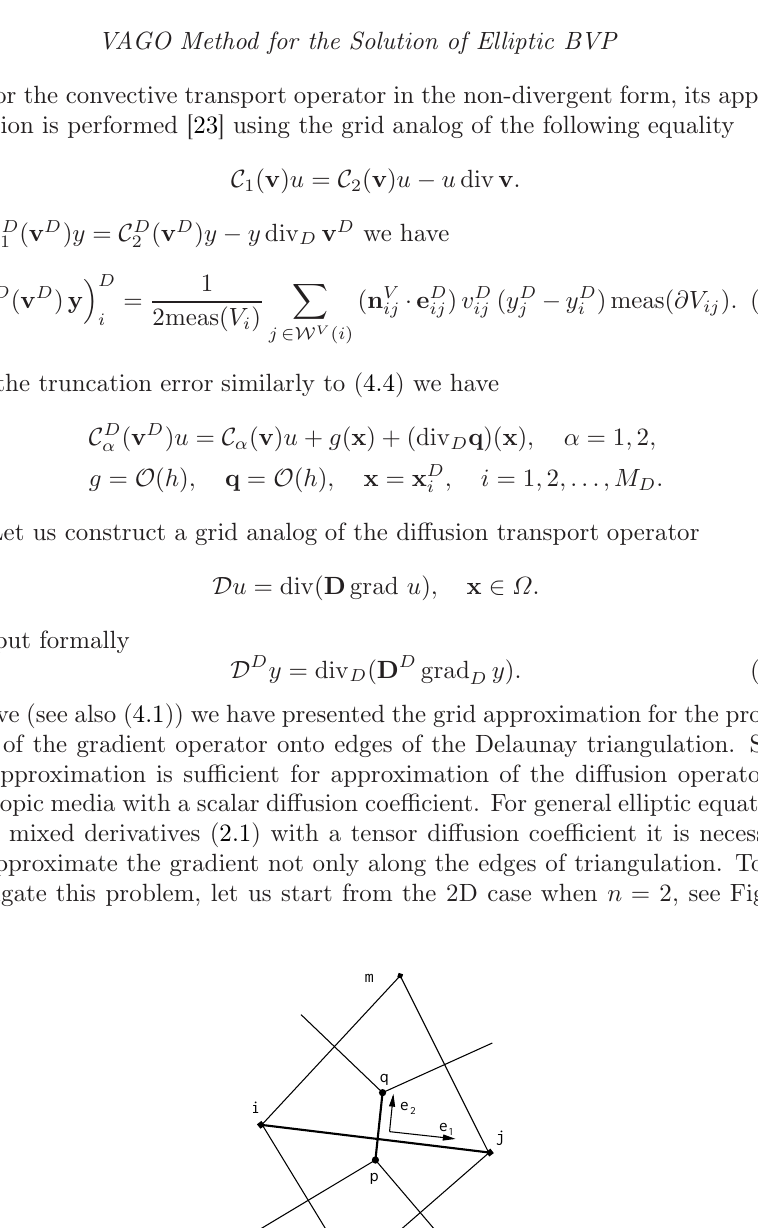
Here i, j, k, m are nodes of the Delaunay triangulation, i, j, k and i, j, m are two adjacent triangles of this triangulation with common edge ( i, j ) , and p , q denote nodes of the Voronoi diagram. For nodes of the Voronoi